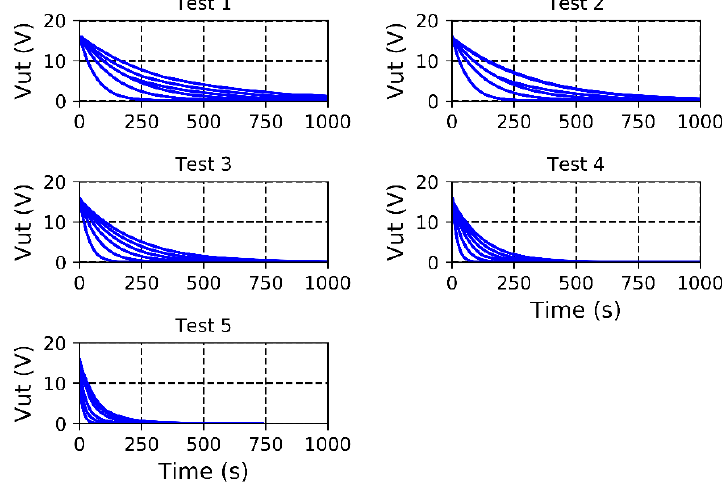
Figure 28. Power while discharging grouped according to the number of the test. Using results presented in Figures 21–28, it was possible calculate the energy stored in the ultracapacitors and the efficiency. The results for energy calculations in the ultracapacitors are presented in Table 12. Table 12. Results for energy calculation in the ultracapacitors. Variable